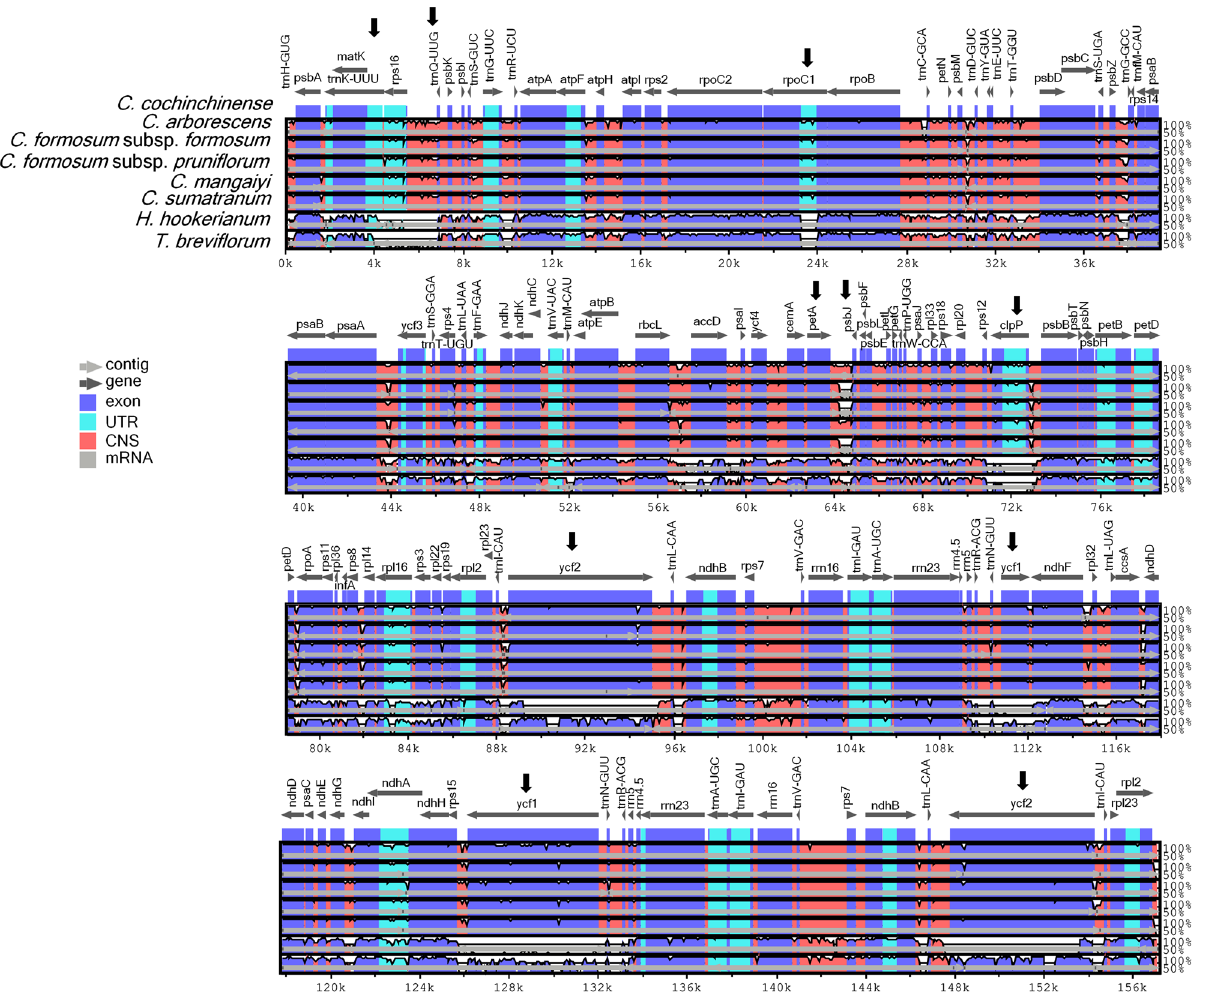
Figure 4. Genome comparative analysis of seven taxa of Hypericaceae used in this study, with the complete plastid genome sequence of Cratoxylum cochinchinense (MN399961) as the reference genome. Analysis was conducted using mVISTA under Shuffle-LAGAN mode. Figure legend describes the direction and types of gene regions using color codes. Probability threshold was set at 50%. Black arrows indicate regions that display distinct divergence in the plastid